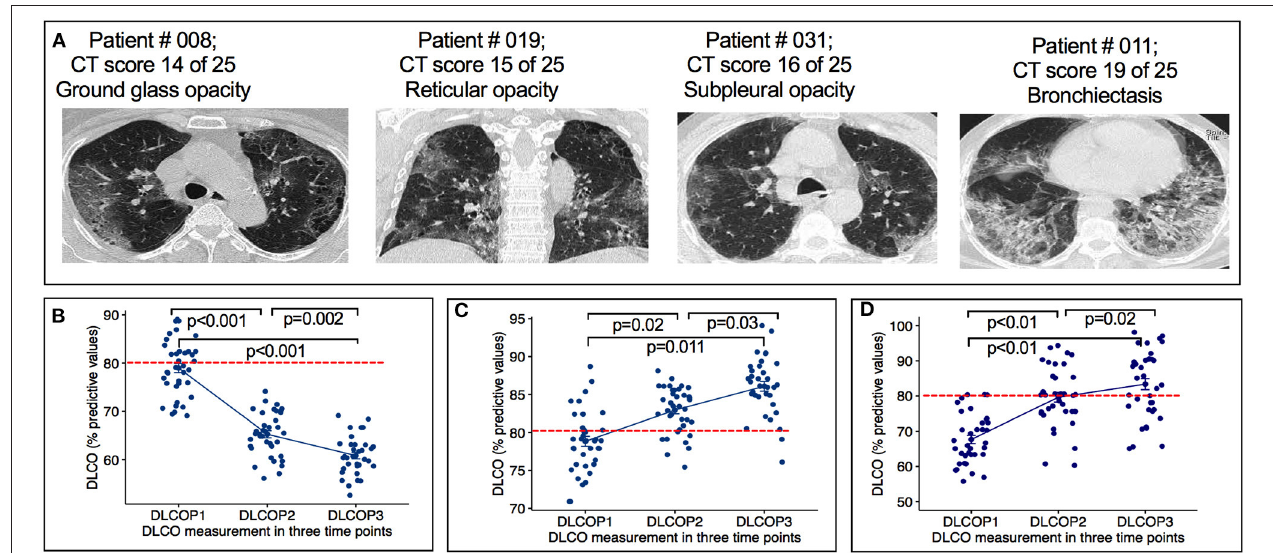
FIGURE 2 | Radiographic features of HRCT images and DLCO measurement from COVID-19 infected cancer patients. (A) Representative images showing ground glass opacity, reticular opacity, subpleural opacity and bronchiectasis of indicated patients. (B) Figure show the changes in lung diffusion for carbon monoxide (DLCO) at each time point. SARS-CoV-2 infected cancer patients treated with chemotherapy before (P1), after first cycle of chemotherapy (P2) and 10 weeks after the end of chemotherapy (P3). P < 0.0001: changes of DLCO from P1 to P2, p = 0.002: Changes of DLCO from P2 to P3. (C) Graph show the change of DLCO of cancer patients treated with chemotherapy 2–6 months before SARS-CoV-2 infection at three time points. Changes of DLCO from P1 to P2, p = 0.02: changes of DLCO from P2 to P3, p = 0.03. Horizontal broken red line indicates the normal cutoff of 80%. (D) Graph show the change of DLCO of non-cancer SARS-CoV-2 infection only patients at three time points. Changes of DLCO from P1 to P2, p < 0.01: changes of DLCO from P2 to P3, p = 0.02. Horizontal broken red line indicates the normal cutoff of 80% predicted. DLCOP1, measurement of DLCO before administering chemotherapy; DLCOP2, measurement of DLCO after first chemotherapy cycle, DLCOP3, measurement of DLCO ten weeks after the end of chemotherapy. Horizontal broken red line indicates the normal cutoff of 80% predicted.